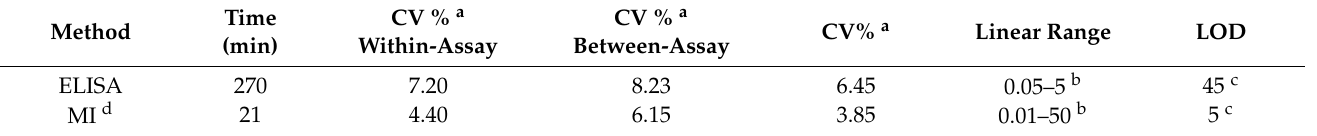
Table 1. Comparison of the analytical performance between the commercial ELISA kit and the microfluidic immunosensor for PSA cancer biomarker.